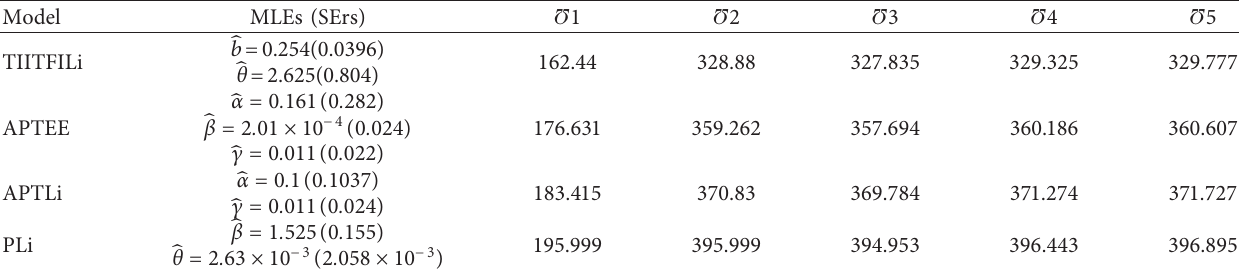
Table 1: Analysis results for the first